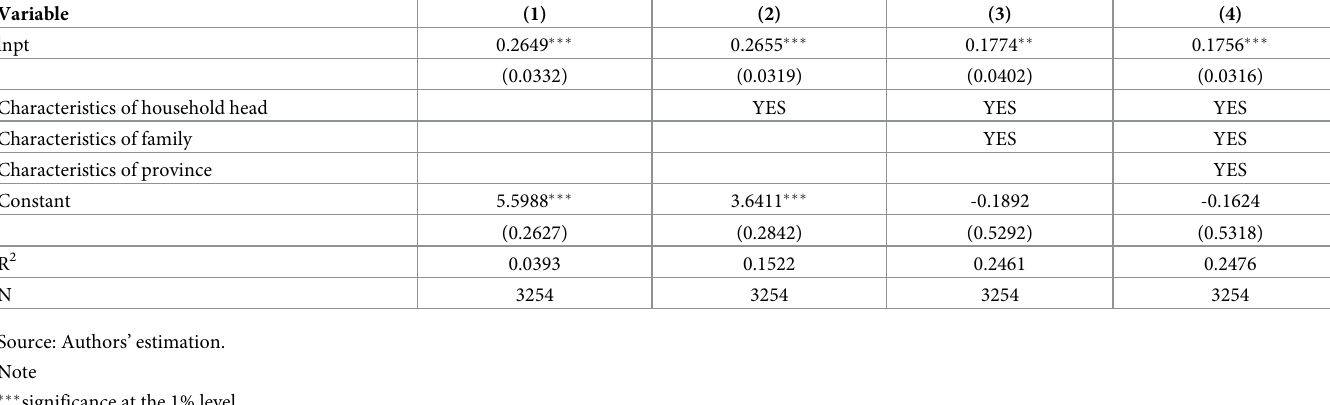
Table 4. Regression results for the replacement of explanatory variables.